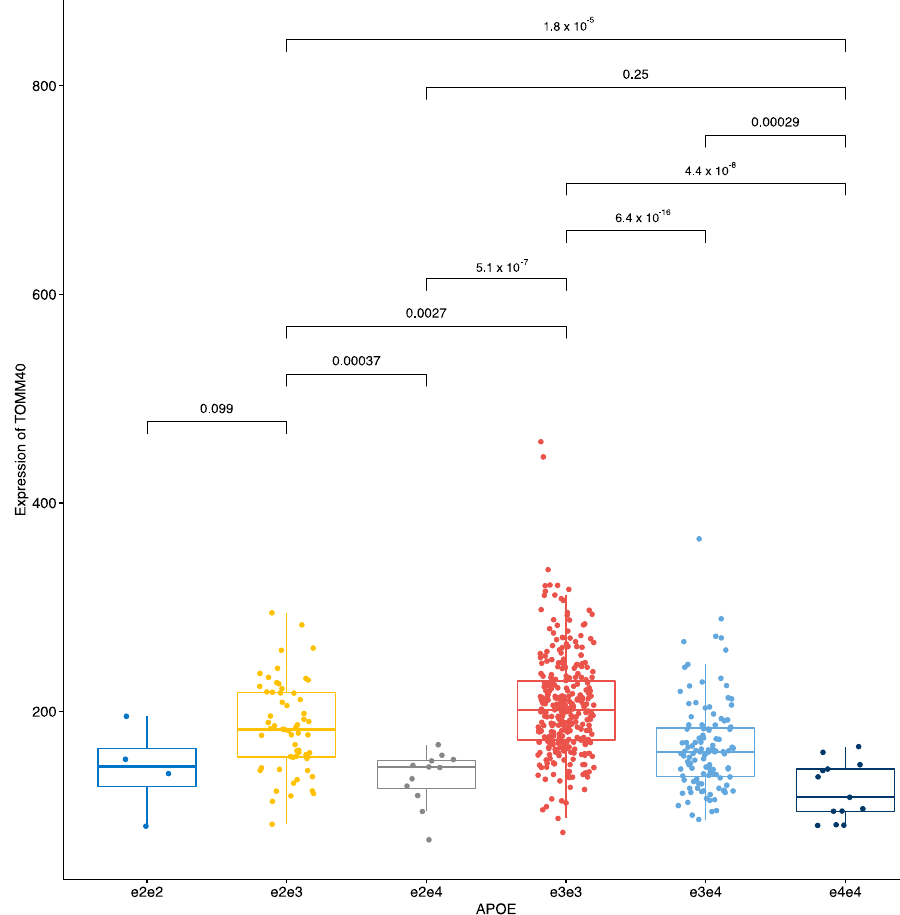
Figure 2. ApoE haplotypes differentially regulate the expression of the TOMM40 gene. The gene signal in this figure is aggregated from all RNA isoforms. ApoE e4 haplotype has statistically significantly lower expression than other haplotypes. Even single e4 allele was sufficient to significantly reduce expression of the TOMM40 gene. The bars in this figure and in all other figures show pairwise comparisons and respective p -values after the Wilcoxon test.